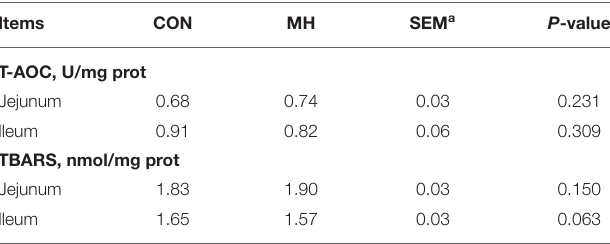
TABLE 6 | Effects of moderate-high dose LM1 on T-AOC and TBARS of colonic mucosa in growing